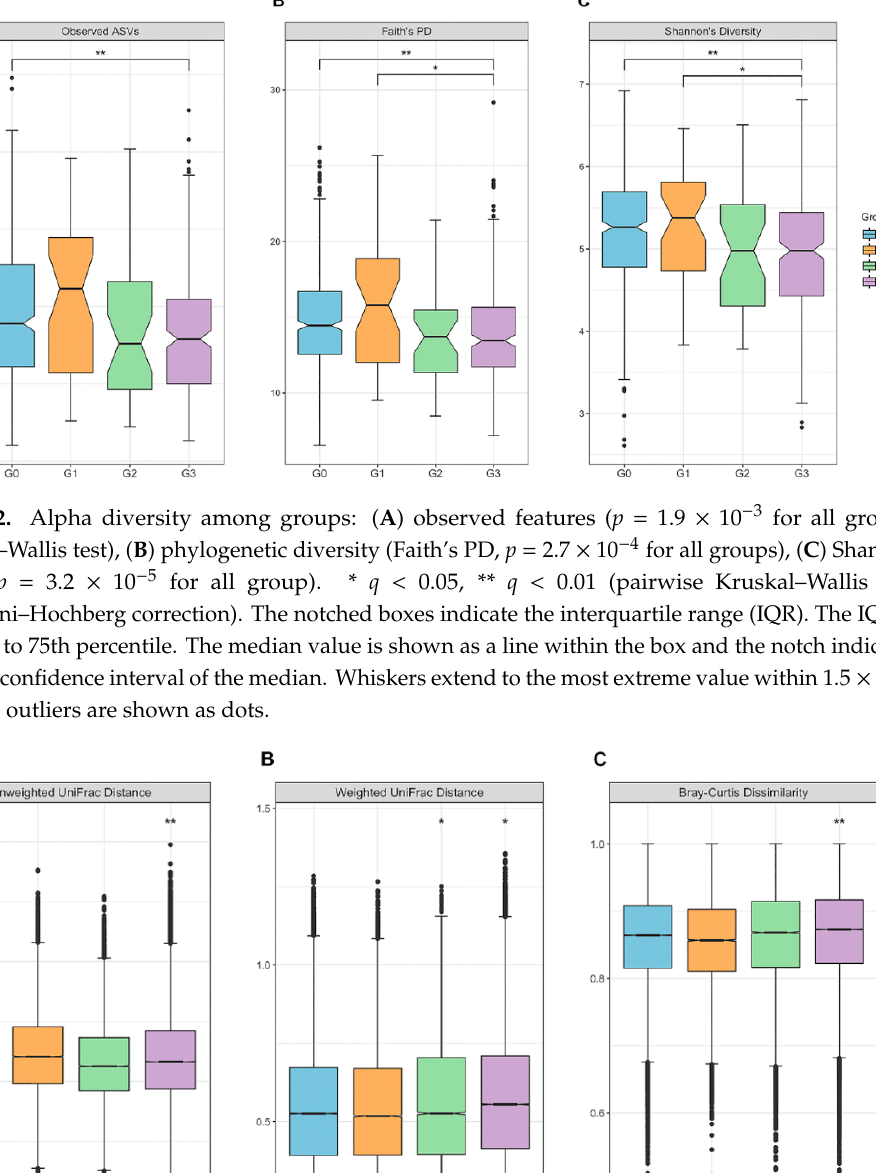
Figure 3. Beta diversity among groups: ( A ) unweighted UniFrac distance ( p = 0.001 for all groups, permutational multivariate analysis of variance (PERMANOVA)), ( B ) weighted UniFrac distance ( p = 0.003 for all groups, PERMANOVA), and ( C ) Bray–Curtis dissimilarity ( p = 0.01 for all groups, PERMANOVA). The y -axes represent the distance of each group to the G0 group (baseline). The line in each box indicates the median of the data. The p -values among all groups were estimated using PERMANOVA with 999 permutations. The q- values were estimated using pairwise PERMANOVA (* q < 0.05, ** q < 0.01).